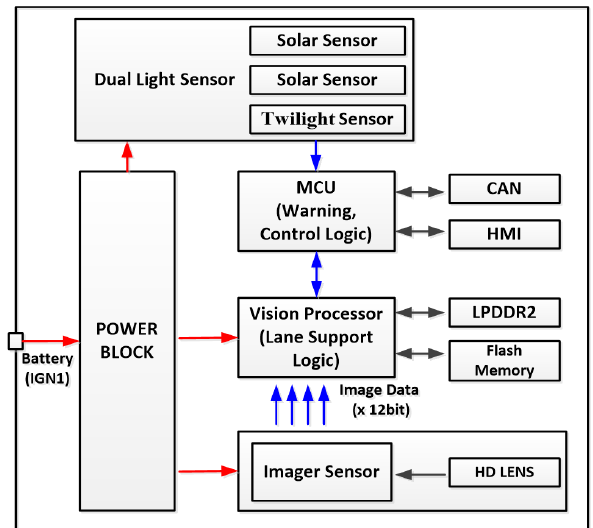
Figure 15. Actual design for circuit board of proposed integrated front camera module dual light